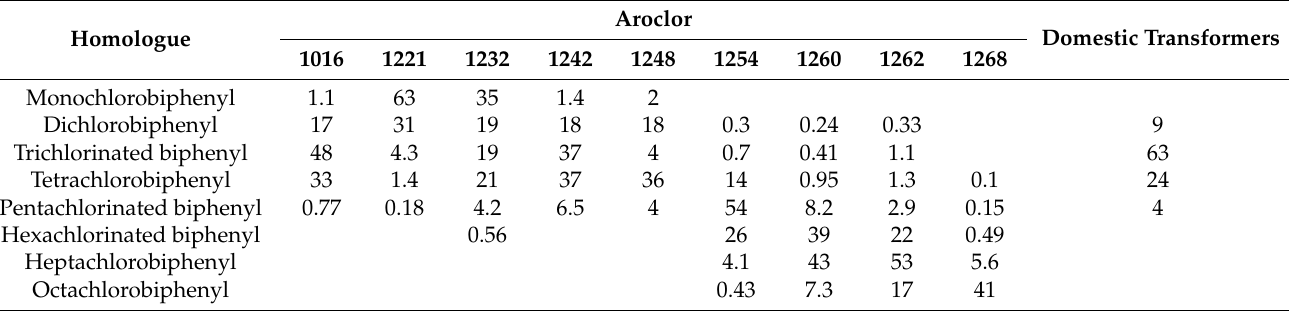
Table 4. Main components of some PCB products